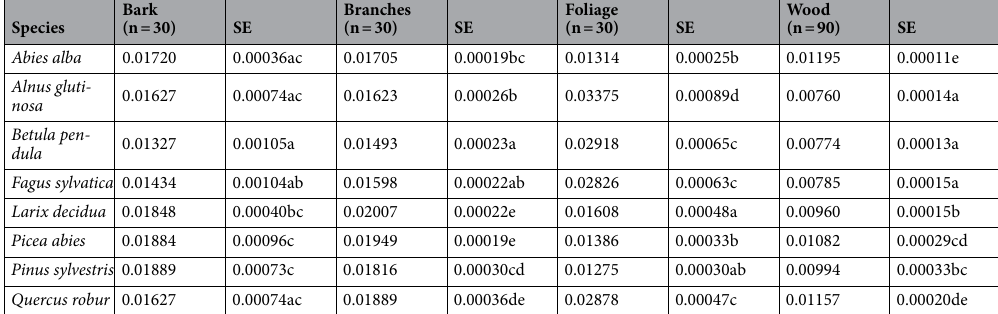
Table 3. Mean and SE of difference in dry mass between two drying temperatures (D) for each biomass component and species. Species which did not differ statistically significantly (p > 0.05 according to Tukey’s posteriori test) within each component are marked with the same letter.